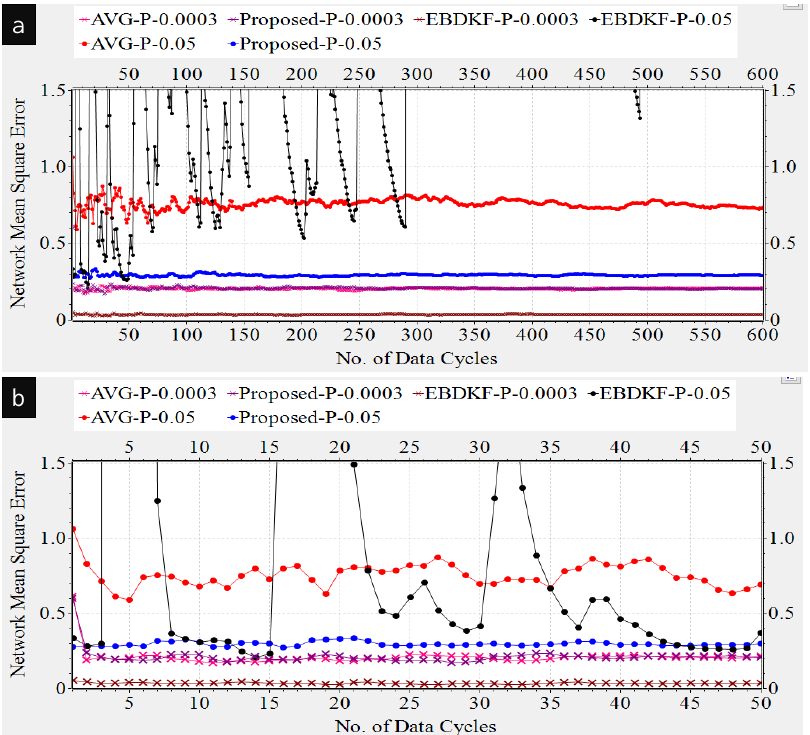
Figure 19. Accuracy comparison with Data gathering cycles for BER s of 0.0003 and 0.05 ( a ): For first 600 Data gathering cycles ( b ): For first 50 Data gathering